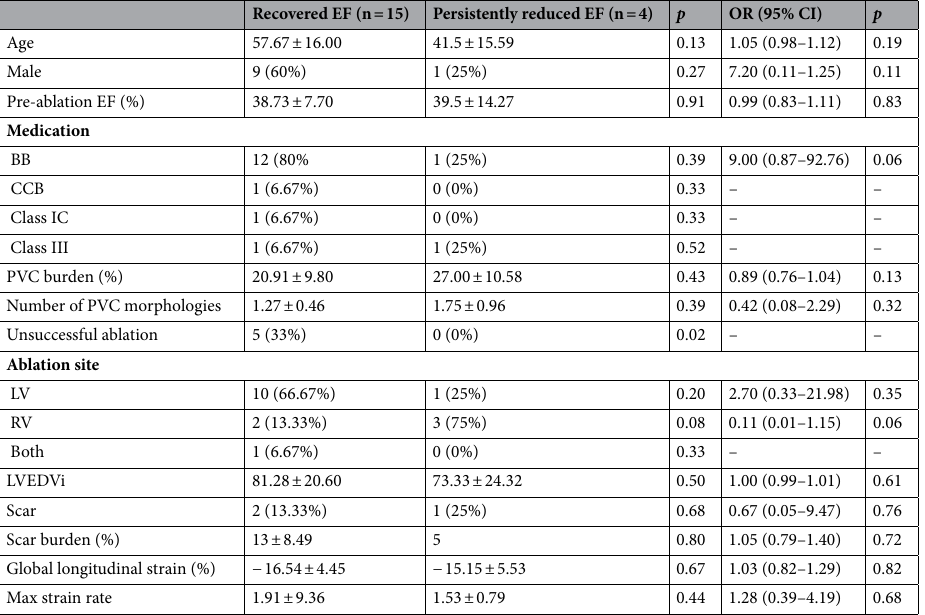
Table 2. Characteristics of cardiomyopathy patients with results of linear